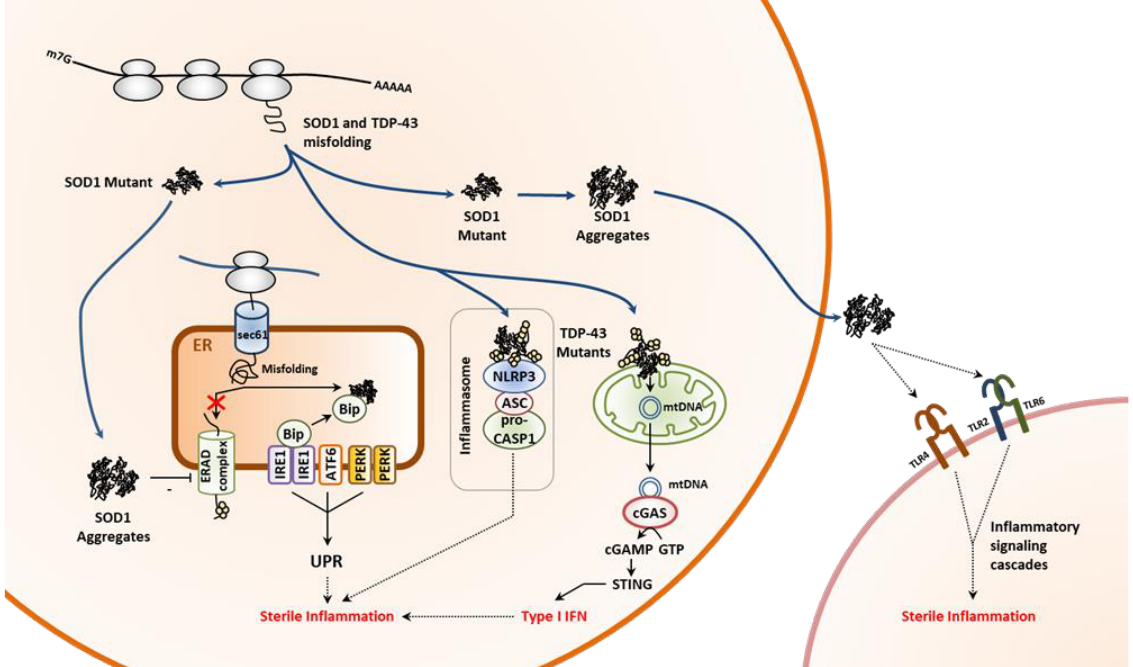
Figure 4. Neuroinflammation caused by impaired proteostasis in ALS involves multiple pathways. Pathogenic variants of superoxide dismutase 1 (SOD1) facilitate the formation of intracellular protein aggregates which themselves promote sterile inflammation by causing persistent activation of the unfolded protein response (UPR) via inhibition of the ER-associated degradation machinery (ERAD), as indicated. In addition, extracellular SOD1 protein aggregates exert their pro-inflammatory effects by binding to phagocyte pattern recognition receptors such as Toll-like receptors (TLR)-2, 4 and 6. Pathogenic mutations within the TAR DNA-binding protein 43 (TDP-43) results in protein aggregation which activates the inflammasome and triggers the release of mitochondrial (mt) DNA. The latter, in turn, initiates a type I IFN response following sensing by the cytosolic cyclic GMP-AMP (cGAS) synthase and subsequent STING activation, as indicated. NLRP3: NOD-like receptor pyrin